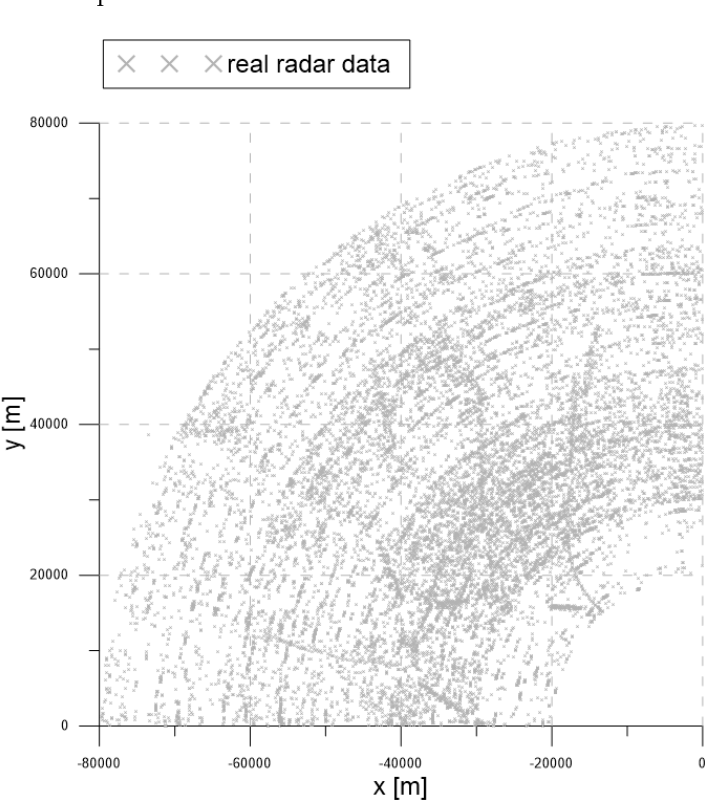
Figure 16. Real radar measurements within the surveillance